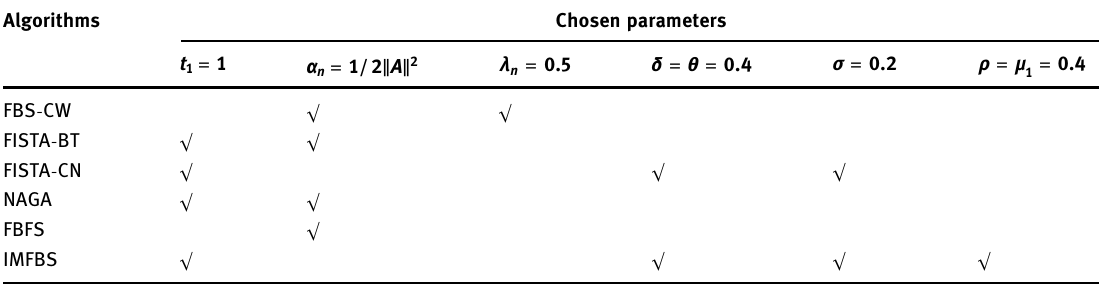
Table 1: Chosen parameters of each